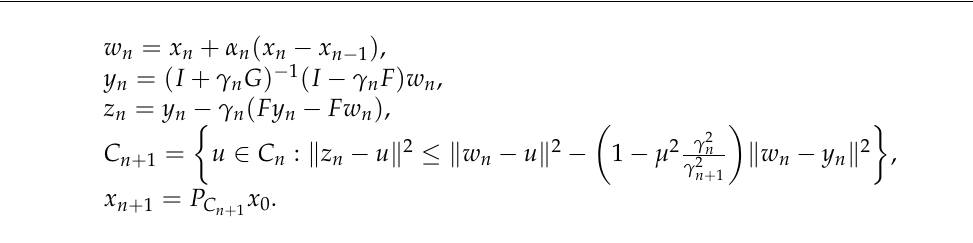
Algorithm 4: Inertial shrinking projection algorithm.